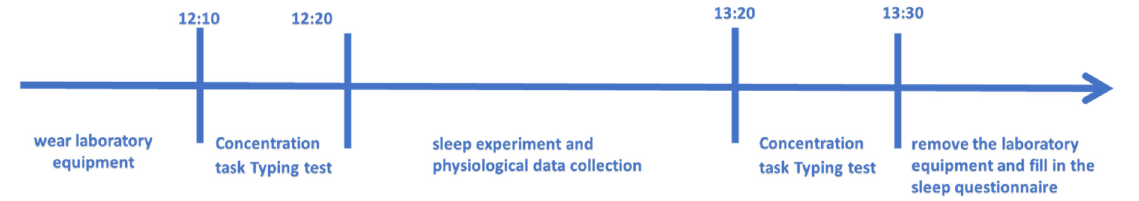
Figure 13. Experimental process. (The typing content topic is different every time, and each subject’s topic is random).